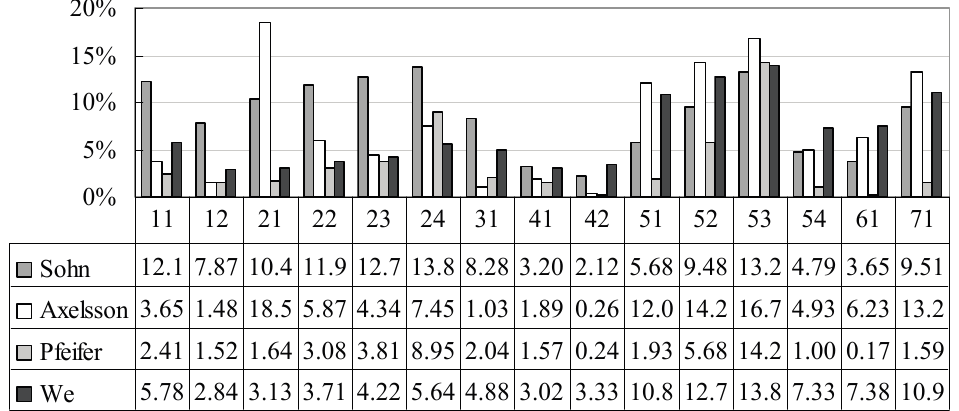
Figure 7. Comparison of type II errors in the filtered sample datasets.